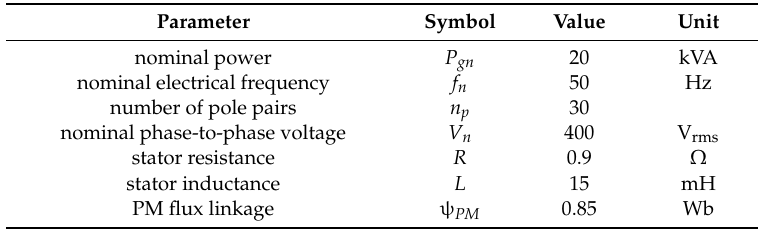
Table 2. PMSG parameters.